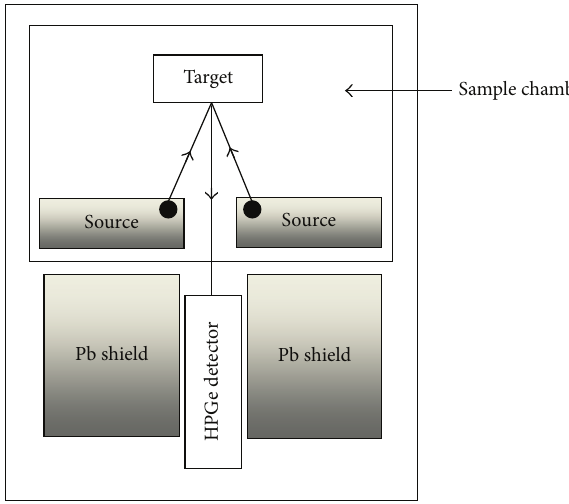
Figure 1: Experimental setup.